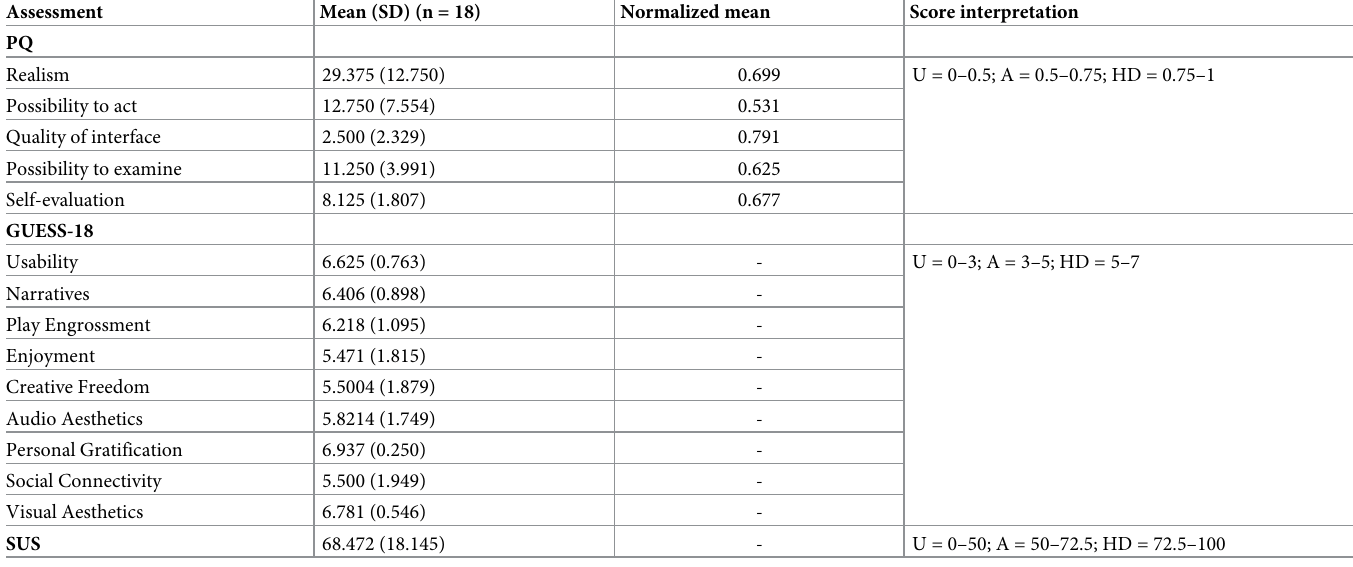
Table 4. Mean and standard deviation (SD) outcomes of Presence Questionnaire (PQ), Satisfaction Questionnaire (GUESS-18) and System usability Scale (SUS) of elderly people. The interpretation of the mean scores for each subscale is provided in the form: U = unacceptable outcome; A = acceptable outcome; HD = highly desirable